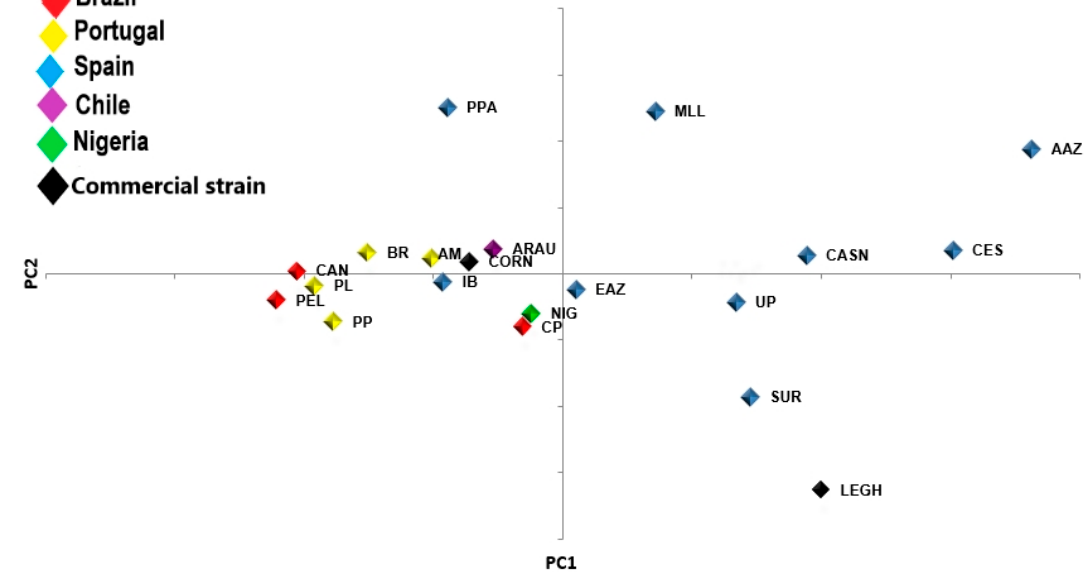
Figure 3. Graphical dispersion of inter-population distances of the 20 genetic groups of chickens in relation to the Cartesian axes obtained by the principal components (PC 1 and PC 2 ) based on the dissimilarity matrix. CP, Canela-Preta; CAN, Caneluda do Catolé; PEL, Peloco; AAZ, Andaluza Azul; CASN, Castellana Negra; CES, Combatiente Español; EAZ, Extremeña Azul; IB, Ibicenca; MLL,